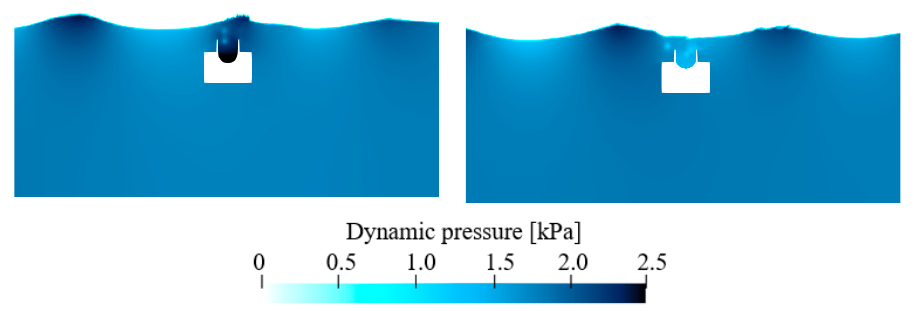
Figure 16. Dynamic pressure contours inside and outside the water chamber when the maximum ( left ) and the minimum ( right ) deformation were reached, respectively.